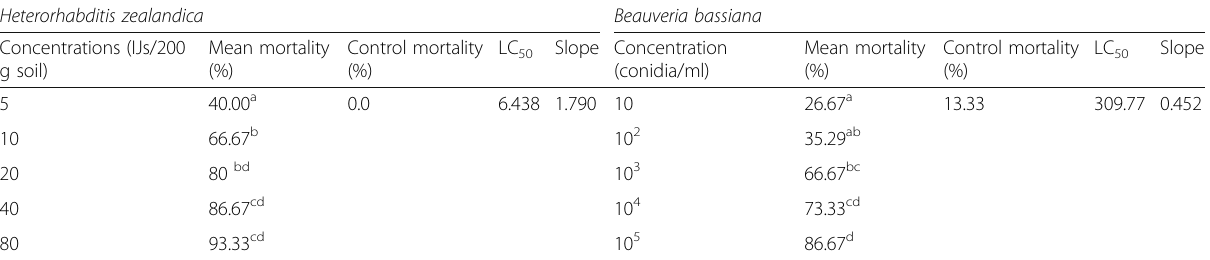
Table 1 Mortality percentage of the last instar Galleria mellonella larvae exposed to the different concentrations of Heterorhabditis zealandica and Beauveria bassiana in response assay Heterorhabditis zealandica Beauveria